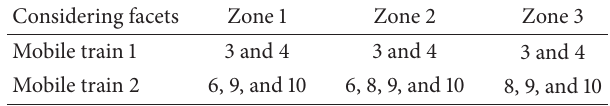
Figure 9: Modelling of propagation environment: (a) the full model, (b) the simplified model in zone 1, (c) the simplified model in zone 2, and (d) the simplified model in zone 3. Table 2: Trains modelling per zone. Table 3: Mean and standard deviation of the absolute errors of the considered characteristic